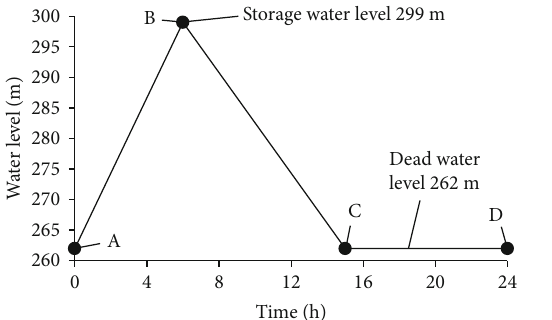
Figure 5: Variation characteristics of reservoir water level in one cycle (1 day/d) during the operating period.